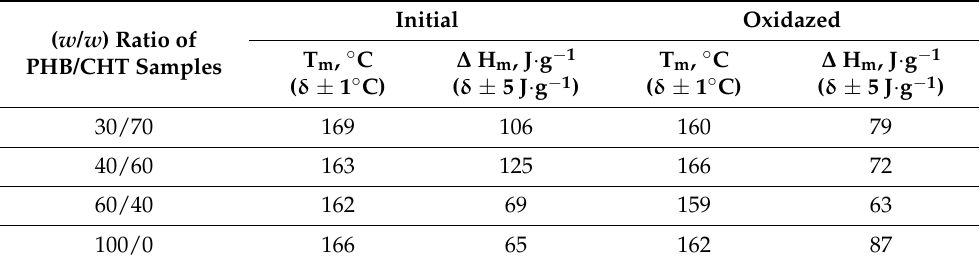
Table 1. Changes in thermophysical parameters melting temperature (T m ) and enthalpy ( ∆ H m ) of PHB/CHT fibrous materials during oxidation for 500 min at 140 ◦